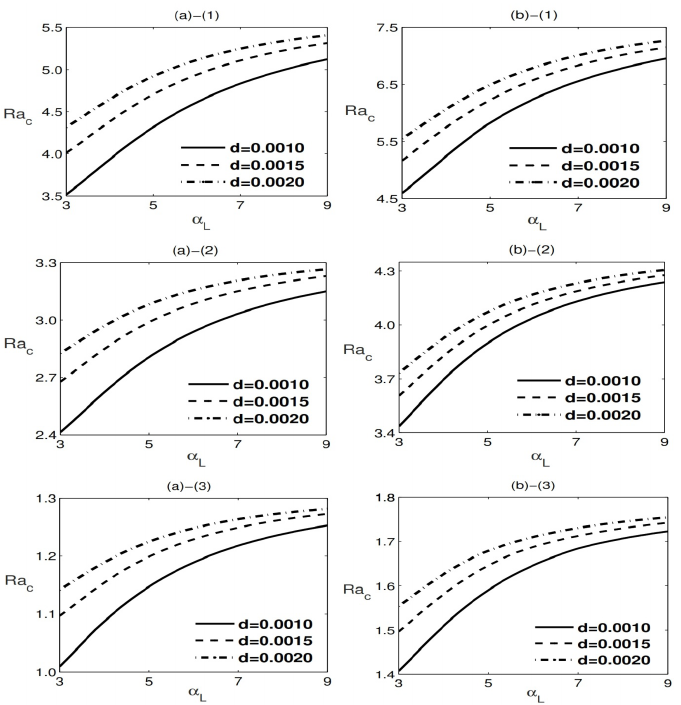
Figure 6: Variation of c Ra as a function of L α for distinct values of d for (a) 1 J = + and (b) 1 J = − ; for (1) I_C-I_C, (2) I_C-I_CHF, and (3) I_C-F_CHF boundaries.